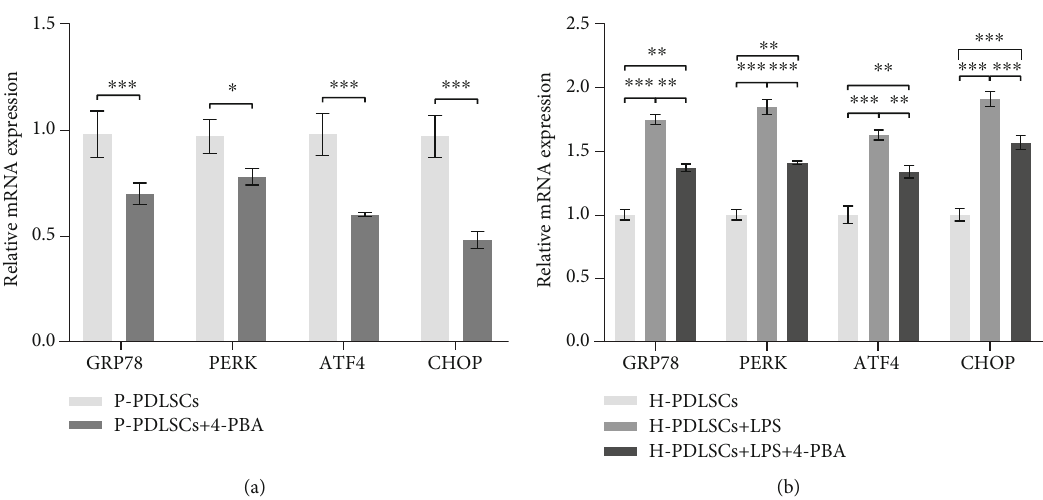
Figure 1: 4-PBA reverses ER stress in PDLSCs under in fl ammatory periodontitis condition. RT-qPCR showed (a) the expression levels of UPR representative genes GRP78 , PERK , ATF4 , and CHOP in P-PDLSCs treated with or without 5 mM 4-PBA for 7 days; (b) the expression levels of UPR representative genes were measured in H-PDLSCs treated in the absence or presence of 10 mg/l LPS or LPS in association with 5 mM 4-PBA for 7 days. The consequences were normalized to the GAPDH gene, and data represent mean ± standard deviations ( n = 3 ). ∗ P < 0 : 05 , ∗∗ P < 0 : 01 , ∗∗∗ P < 0 : 001